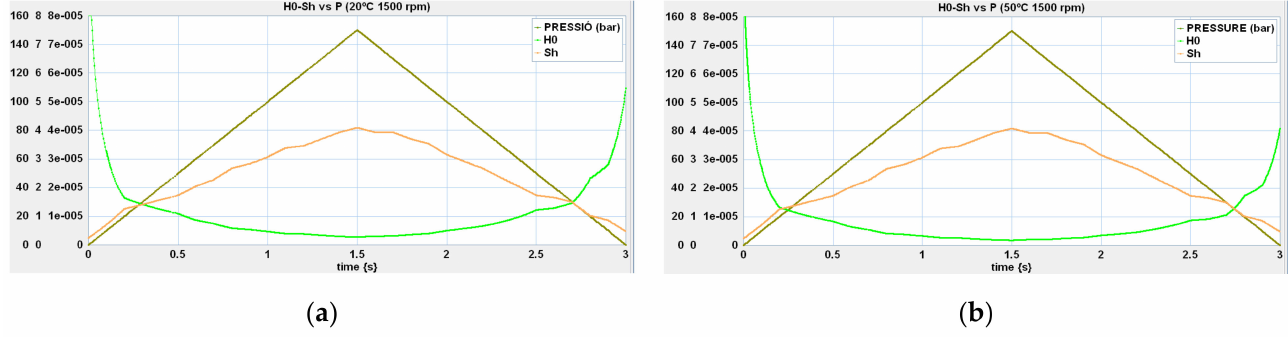
Figure 11. Minimum dimensionless film thickness: H 0 and height S h versus P; ( a ) 1500 rpm 20 ◦ C and ( b ) 1500 rpm 50 ◦ C.